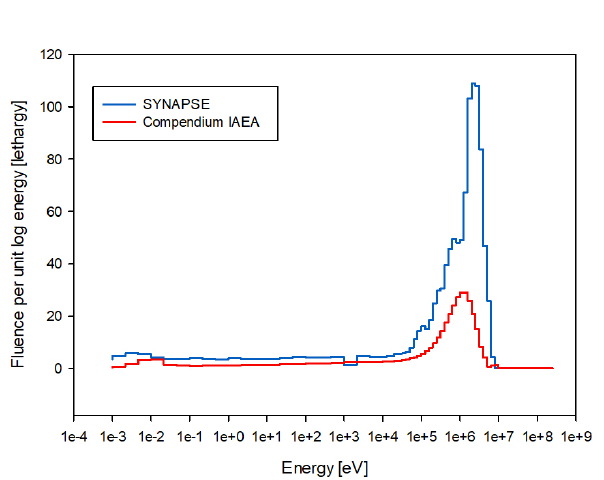
Figure 14. Neutron spectrum unfolding of a 252 Cf neutron